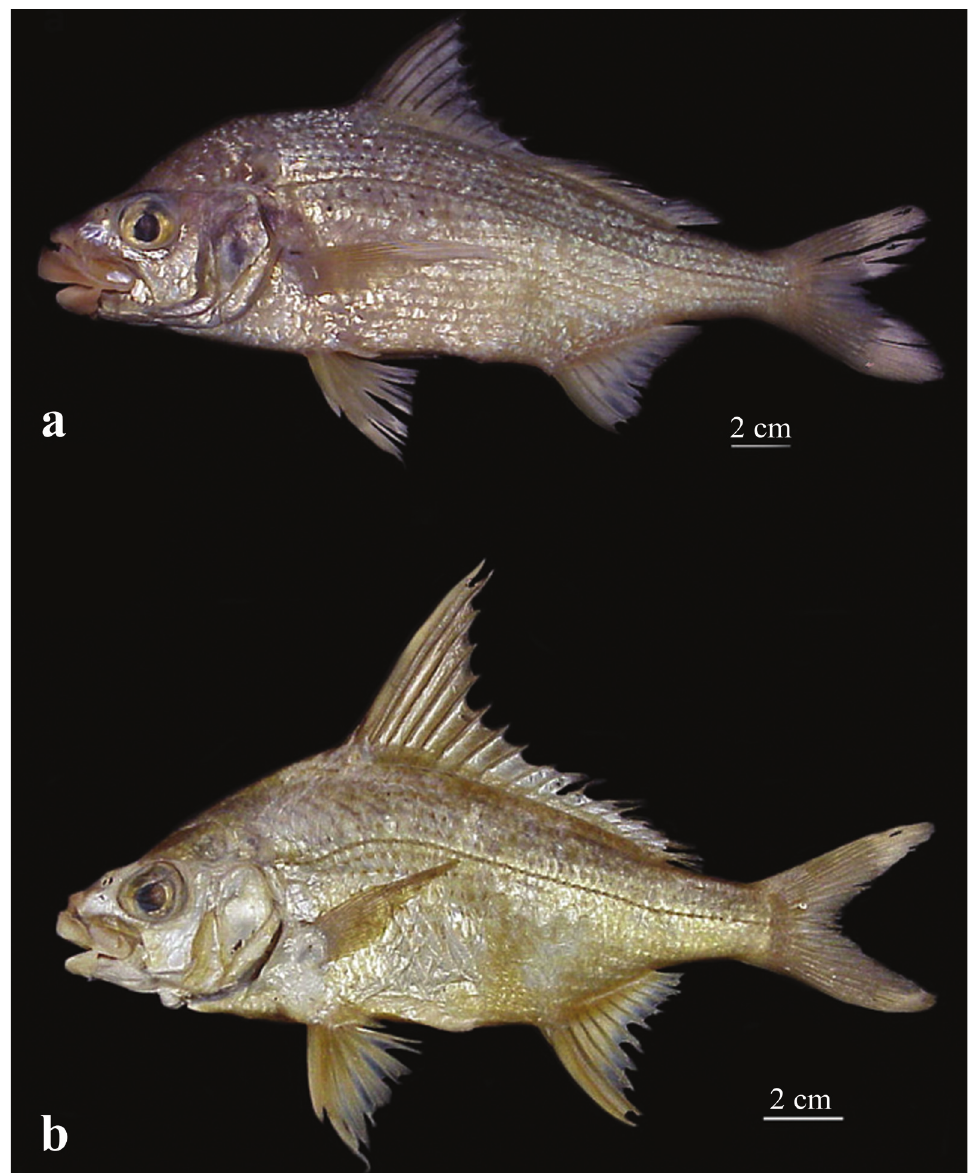
Fig. 3. a ) Eugerres castroaguirrei new species, ECOSC 775, holotype, 184.3 mm SL. México, Chiapas, río Lacantún, Selva Lacandona, Marqués de Comillas, Reforma Agraria and Galaxia; b ) Eugerres mexicanus , NMW 72289, lectotype, 165.6 mm SL. México, Tabasco, Flus (río)